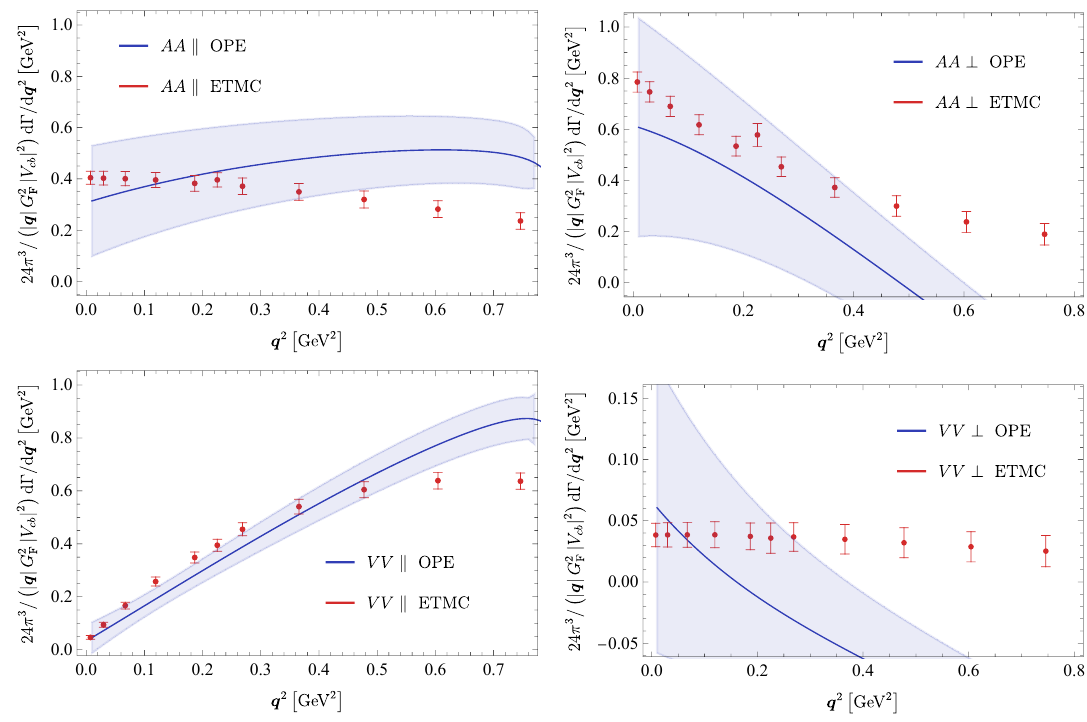
Figure 17 . Differential q 2 spectrum, divided by | q | , in the various channels. The plots show the comparison between OPE and ETMC